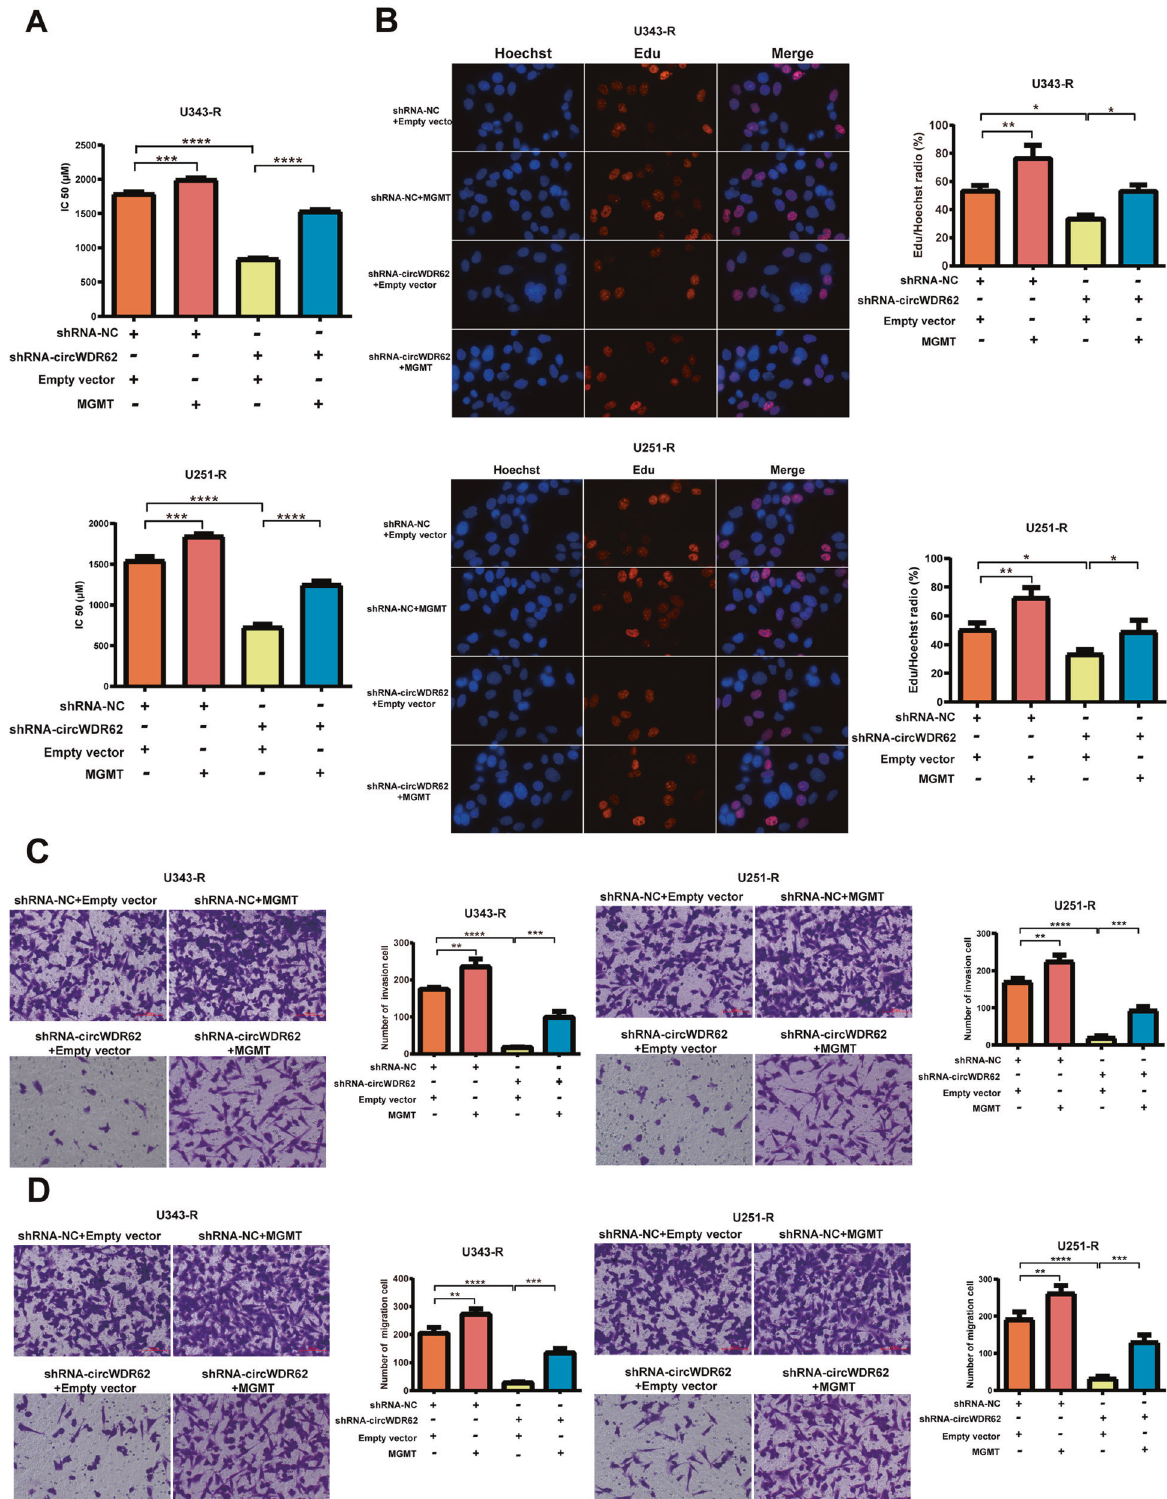
Fig. 5 Overexpression of MGMT reversed circWDR62 knockdown-induced TMZ resistance and malignant progression of glioma cells. U343-R and U251-R cells were transfected with shRNA-NC or shRNA-circWDR62 and MGMT vector or empty vector. A The IC50 of TMZ was measured by the CCK-8 assay. B The EdU assay was performed to assess cell proliferation. C , D Transwell assays were performed to assess cell invasion ( C ) and migration ( D